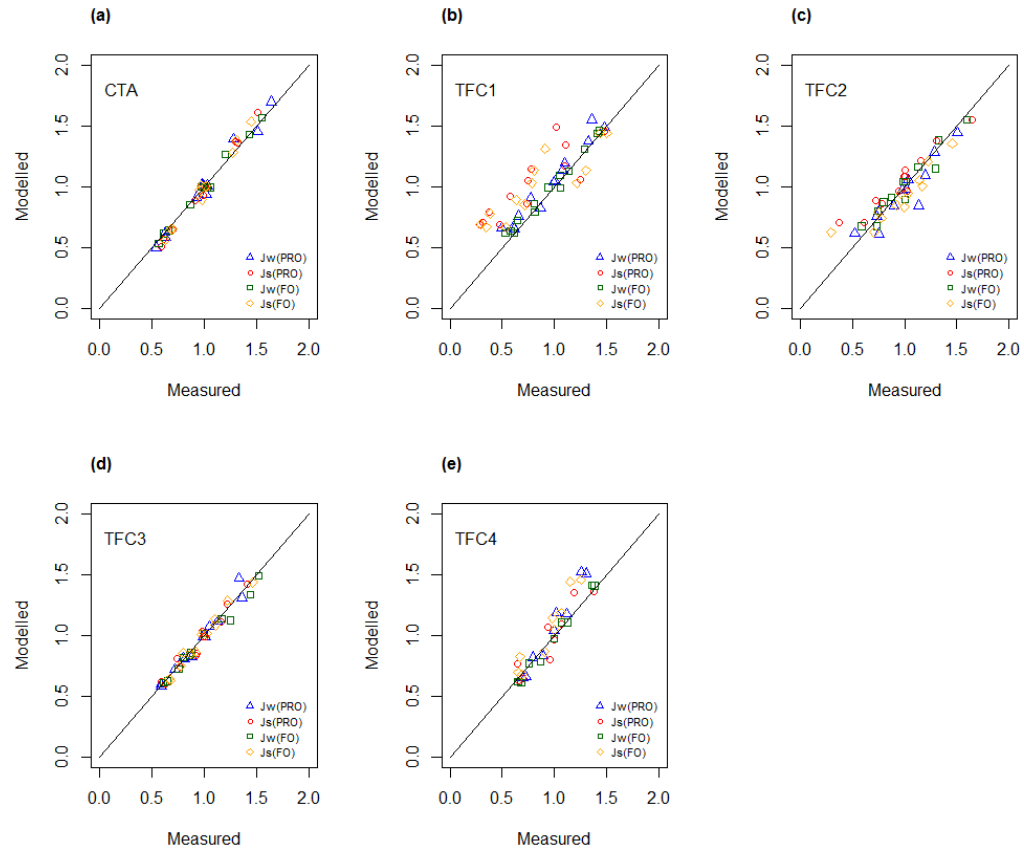
Figure 7. Modelled water and salt fluxes using water and salt permeabilities from Equations (8) and (9), respectively, as function of measured fluxes for ( a ) CTA; ( b ) TFC1; ( c ) TFC2; ( d ) TFC3 and ( e ) TFC4.